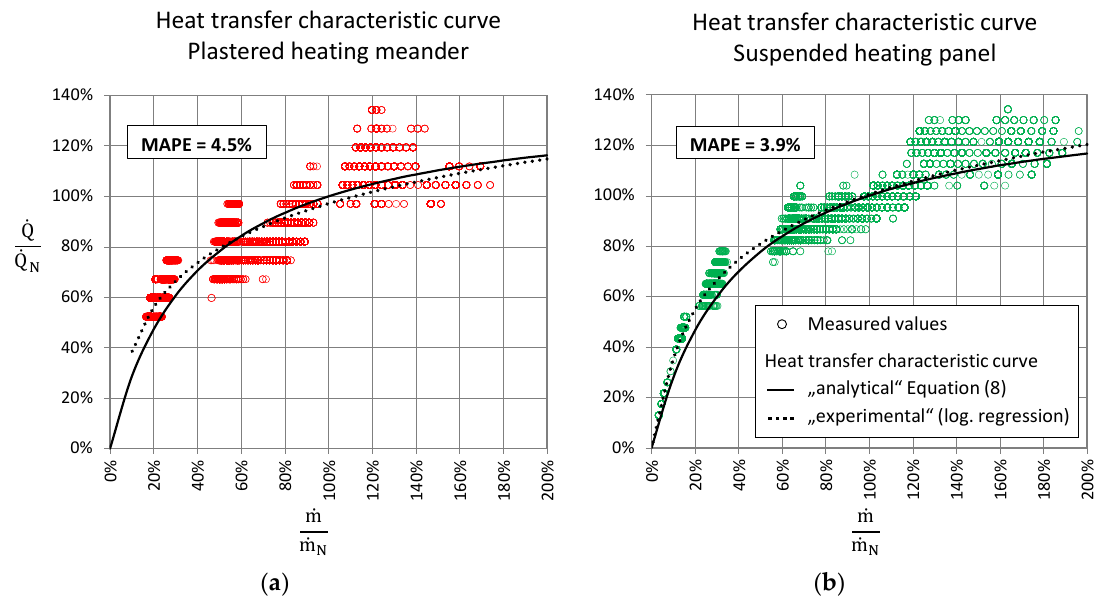
Figure 6. Heat exchanger characteristics for PHM ( a ) and SHP ( b ) as a function of the mass flow ratio.